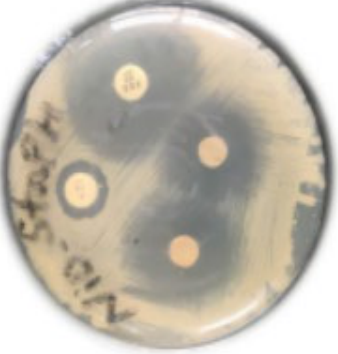
Fig. 7. Lawn culture of Staph. Aureus indicating zone of inhibition around Cu(CH 3 COO) 2 nanoparticle coated discs and standard antibiotic discs after 18 hrs of incubation at 37 ° C